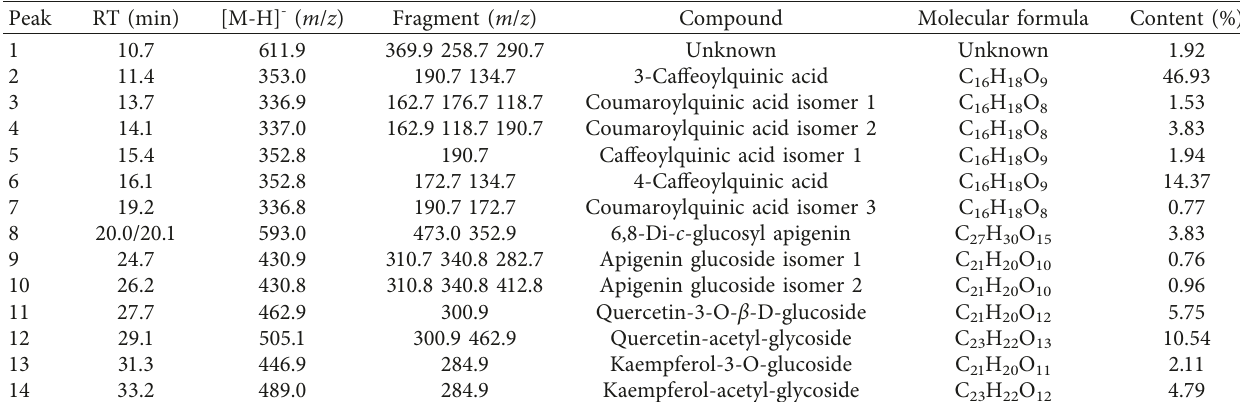
Figure 15: HPLC chromatogram profile of isolated fractions. Table 5: HPLC-ESI-MS data of the compounds identified in